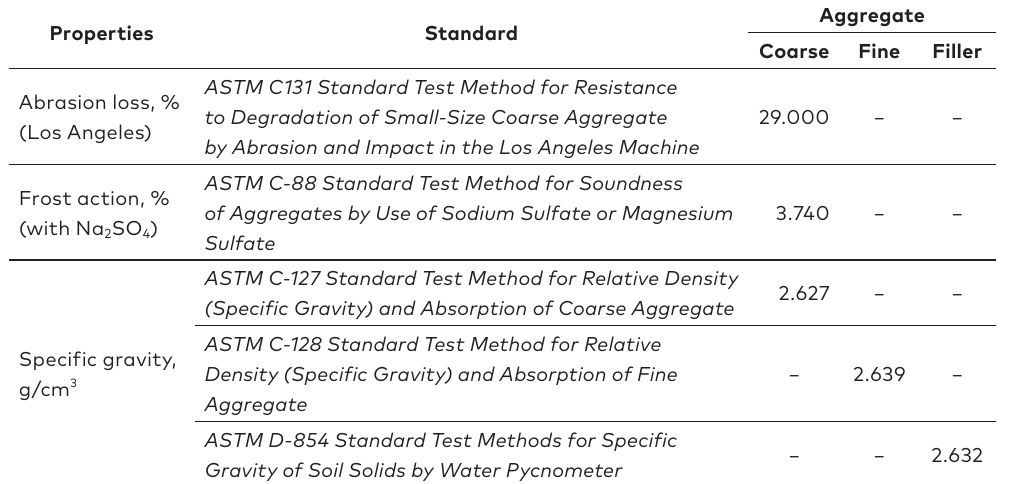
Table 3. Properties of limestone mineral